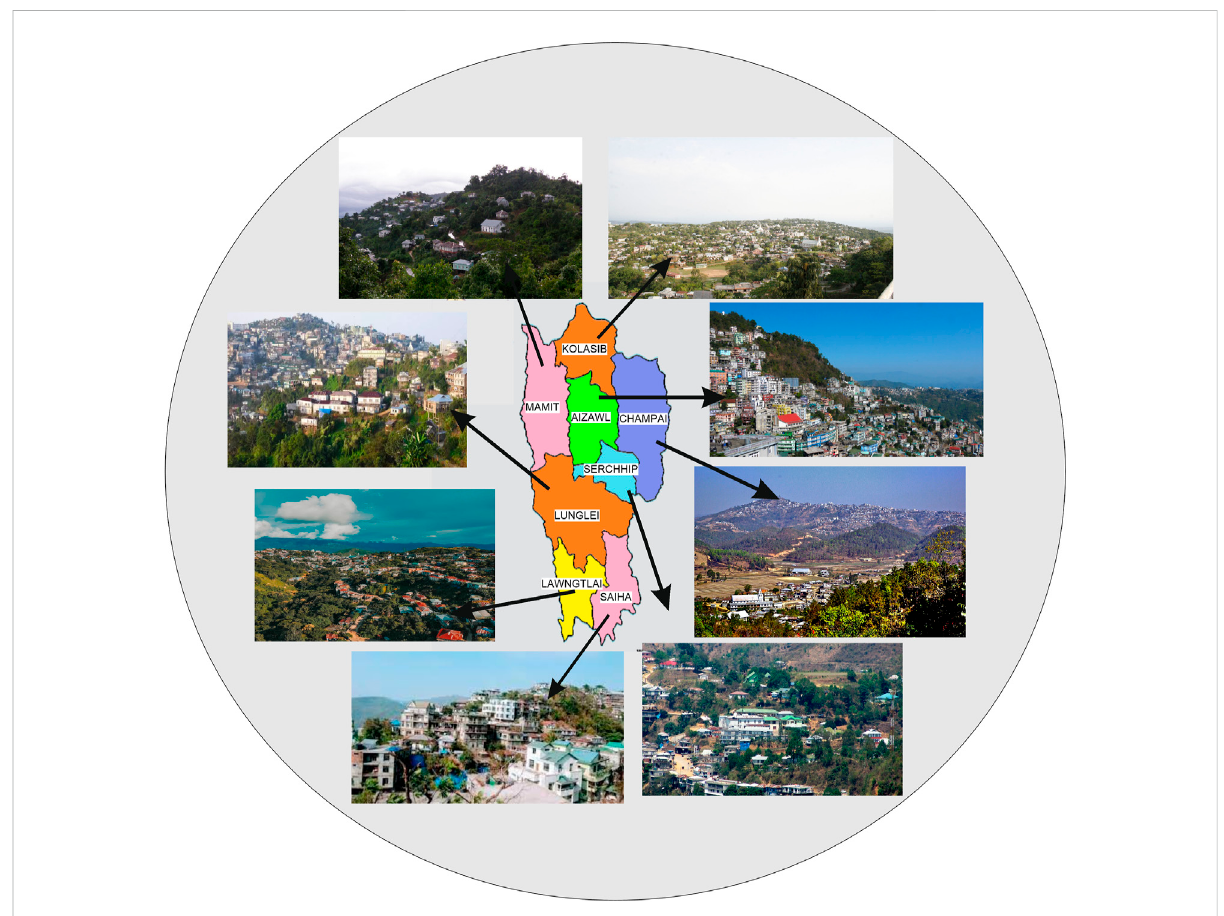
FIGURE 7 Map showing the synoptic view of builtenvironment in divergent geological conditions in different districts of Mizoram state.